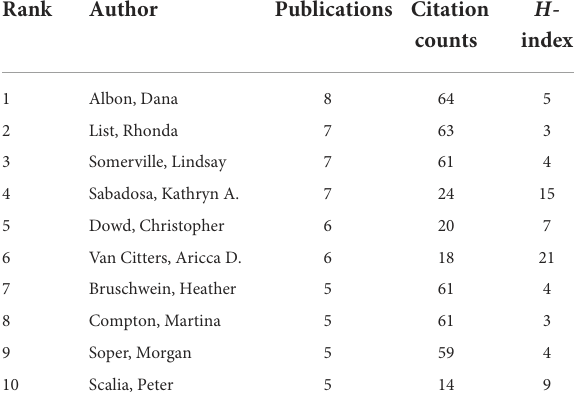
TABLE 5 The ranking of top 10 prolific